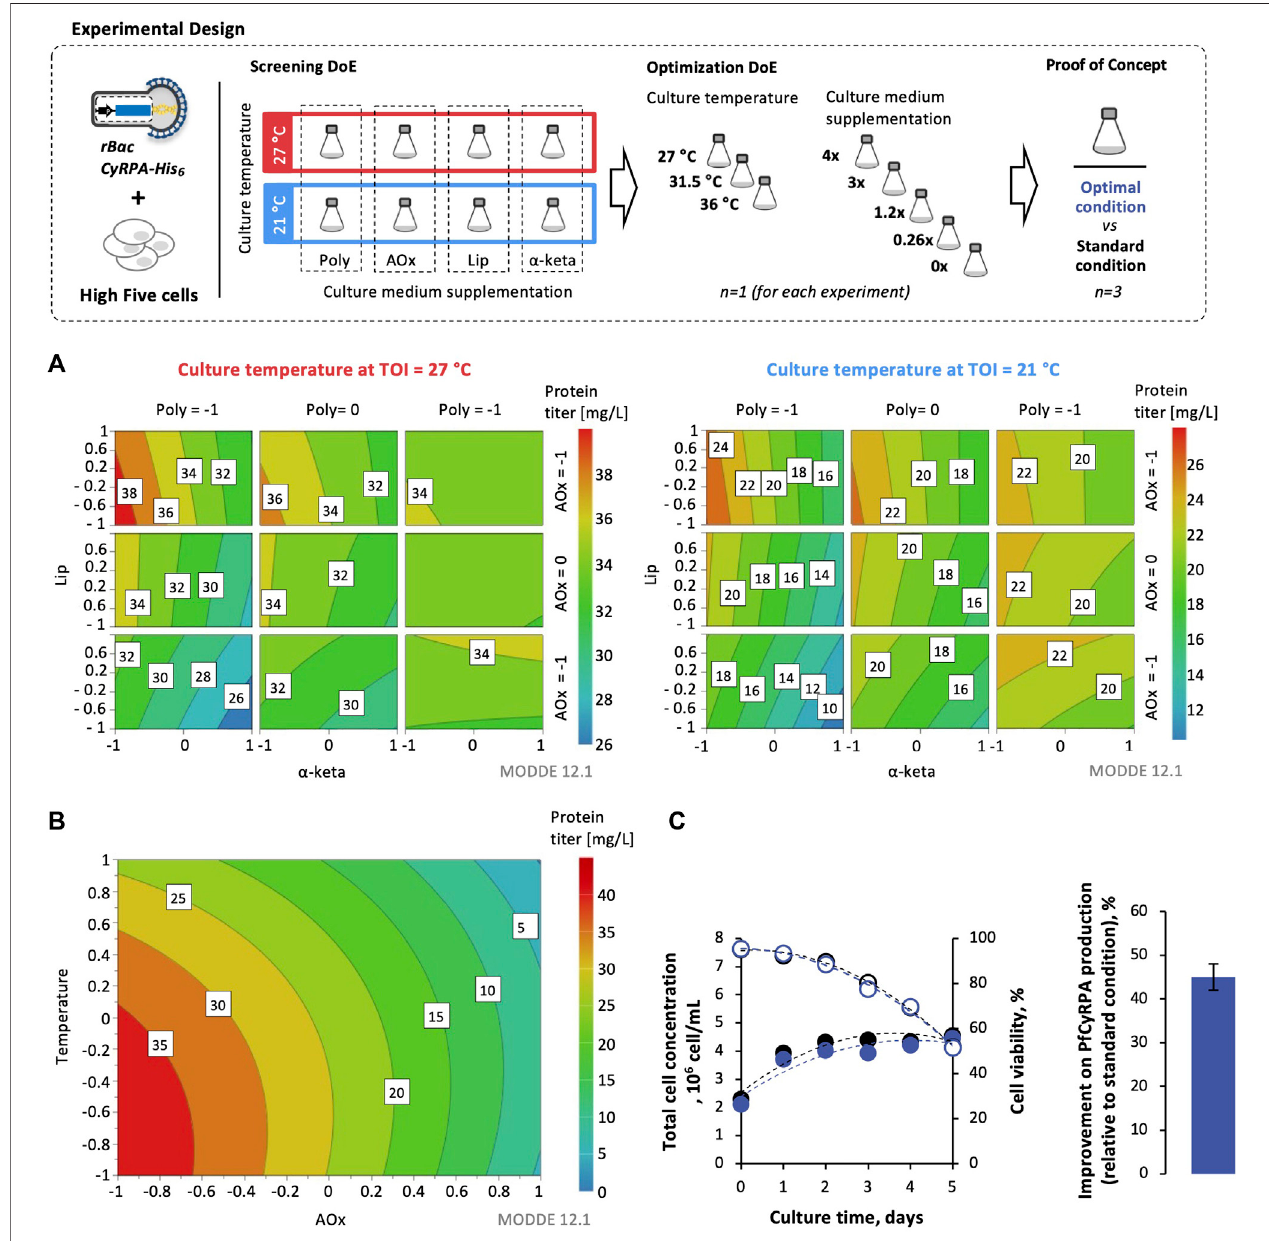
FIGURE 4 | Design of experiments (DoE) for optimizing Pf CyRPA production in High Five cells. Response surface models for Pf CyRPA protein titer (mg/L) from screening experiments (A) and optimization experiments (B) . (C) Cell growth and viability kinetics in optimal conditions identi fi ed by DoE. Improvement of Pf CyRPA protein titer (mg/L) in optimal conditions identi fi ed by DoE vs. standard condition (i.e., cultures at 27 ° C and no supplementation). DoE images were obtained using MODDE ® 12.1Prosoftware(Sartorius).Datainbargraphsareexpressedasmean±standarddeviation(relativetothreetechnicalreplicates, n =3).Abbreviations: TOI, time of infection; Lip, lipids; Poly, polyamines; α -keta, α -ketoglutarate; AOx,